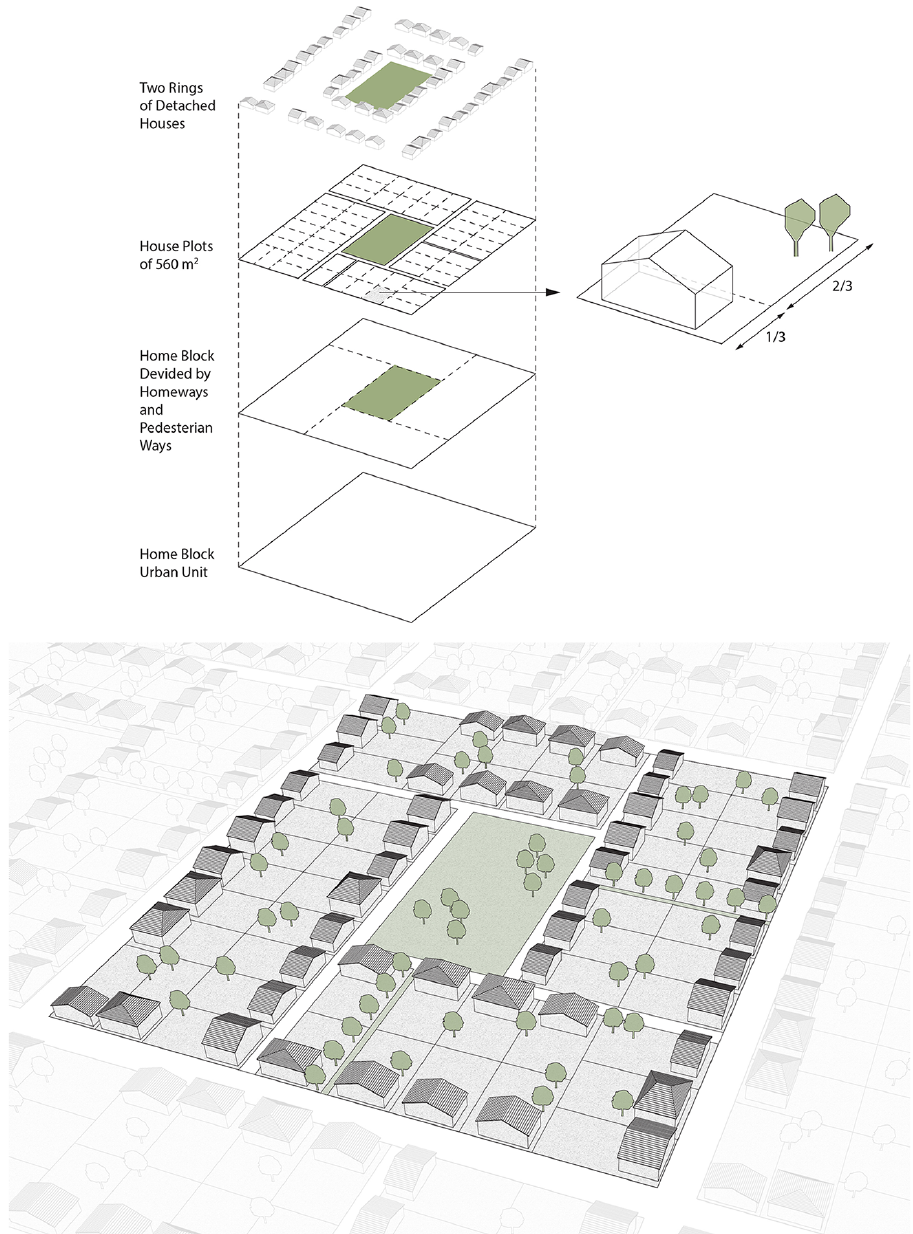
Figure 7. Block scheme after Geddes. Source: